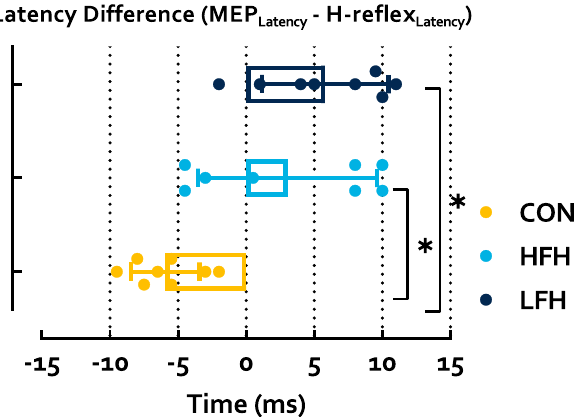
Figure 6. Latency difference derived using SO MEP latency and H-reflex latency. This relationship was significantly more negative in CON than LFH or HFH, while LFH and HFH did not differ. Asterisks represent a p <